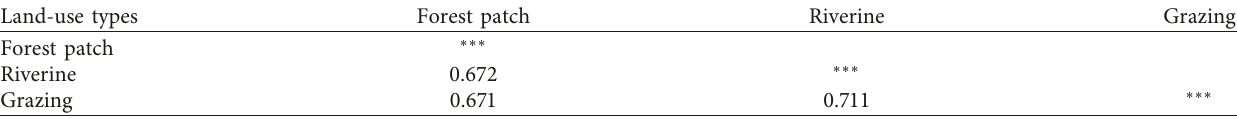
Table 6: Floristic composition similarity indices between the land-use types.